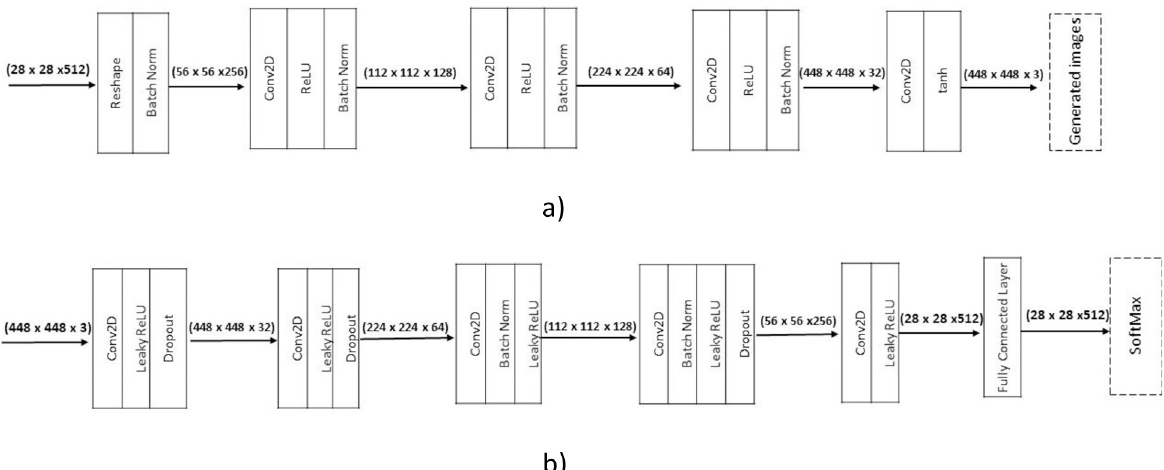
Fig 2. Structure of modified SGAN. a) Generator. b) Discriminator.